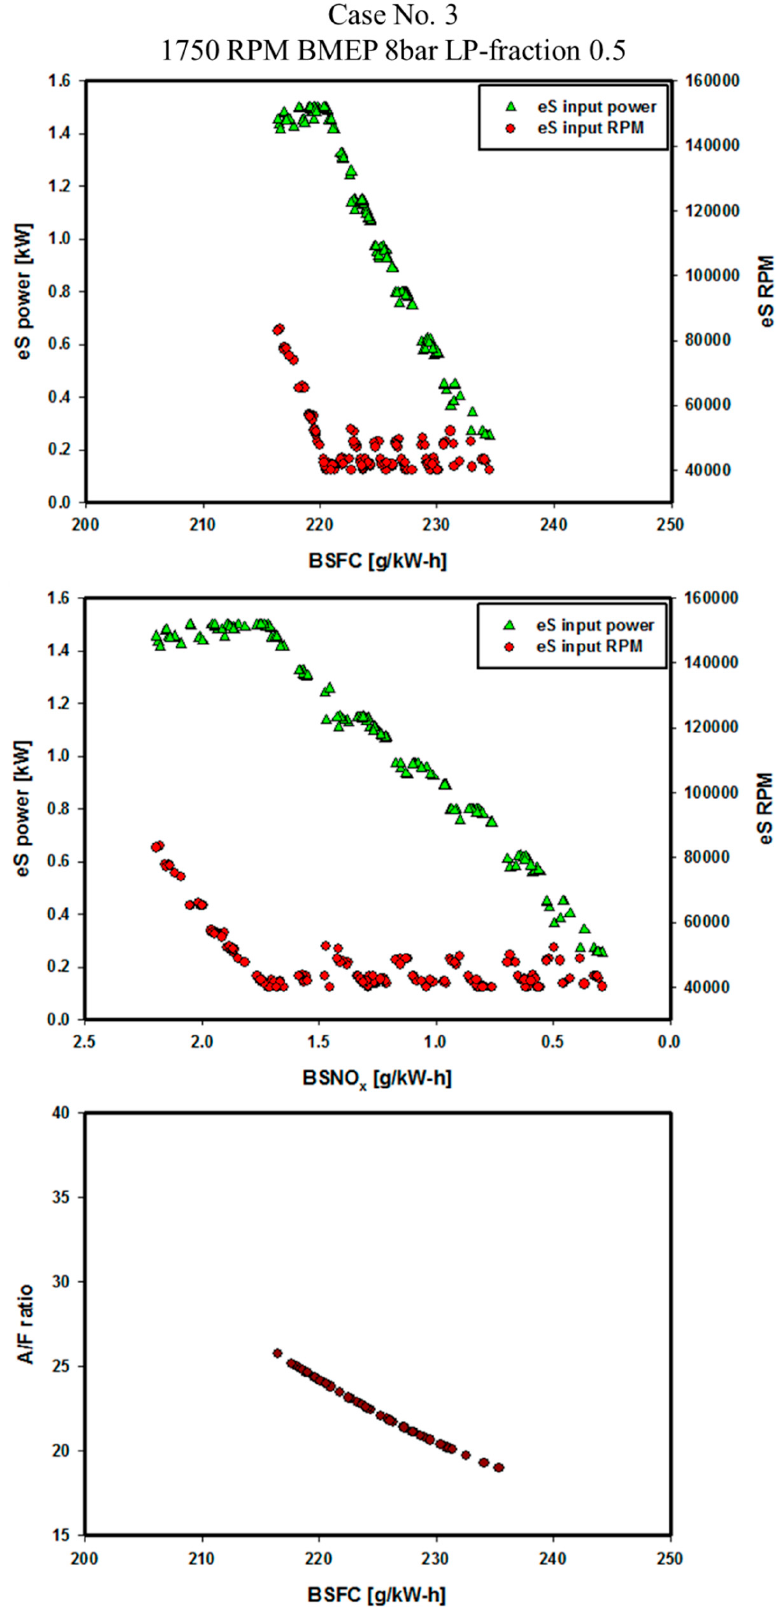
Figure 14. BSFC, BSNO x , and A/F ratio differences on the Pareto front line of case 3 (LP fraction = 0.5).